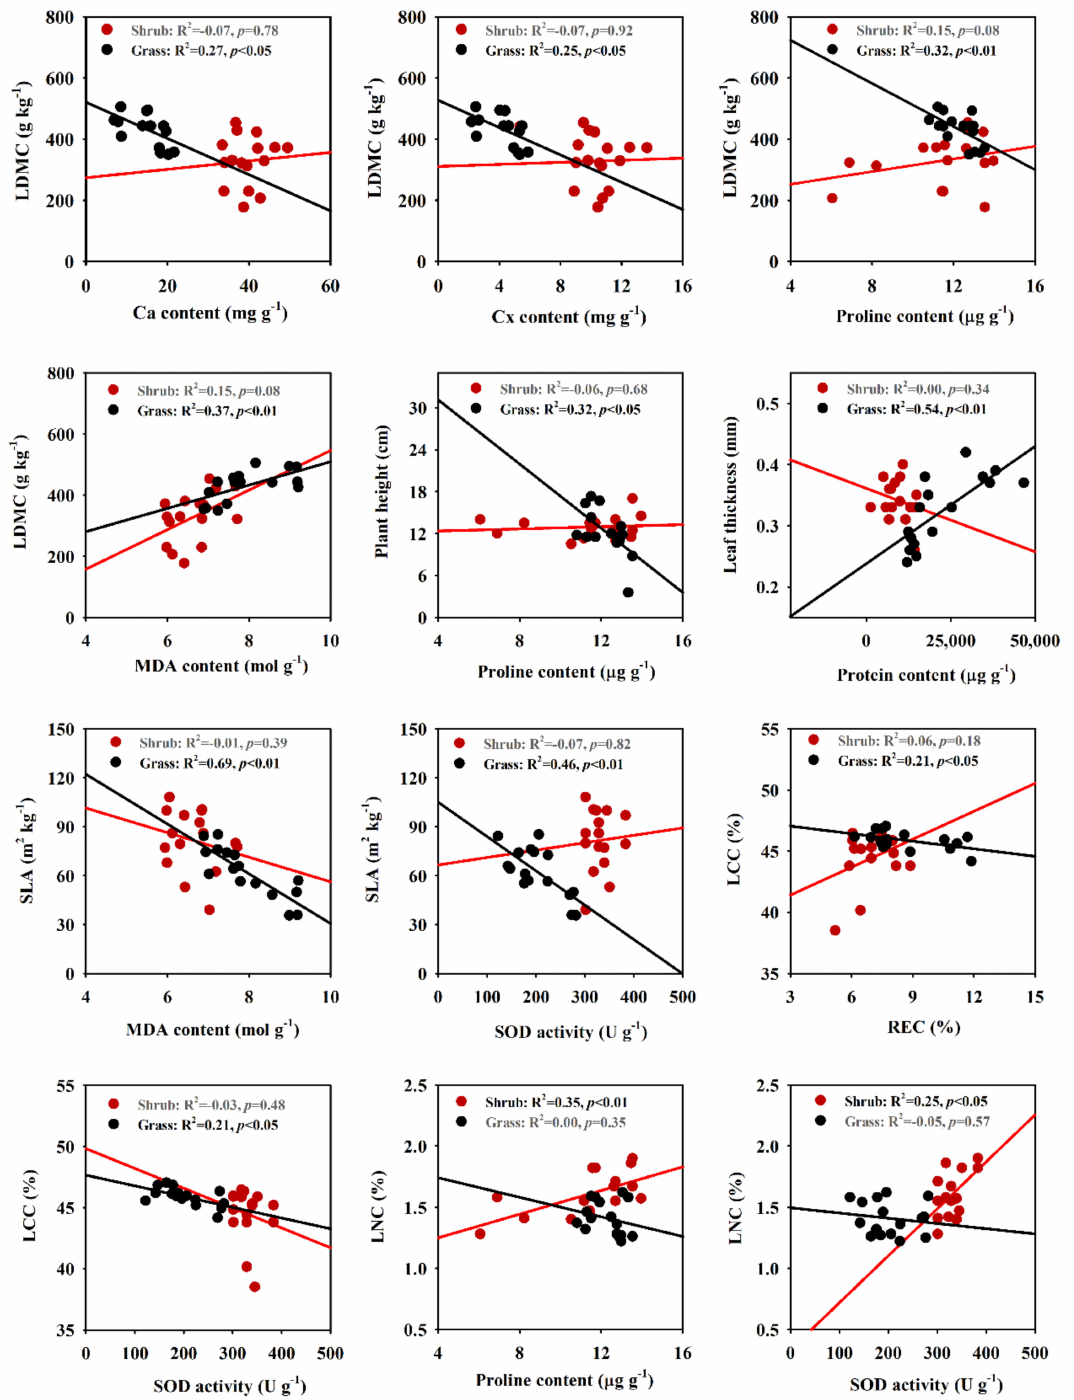
Figure 3. Correlations between functional and biochemical traits of Stipa glareosa in the shrub- and grass-dominated communities. LDMC, leaf dry matter content; Ca, chlorophyll a; Cx, carotenoids; MDA, malondialaenyde; SLA, specific leaf area; SOD, superoxide dismutase; LCC, leaf carbon content; REC, relative electrical conductivity; LNC, leaf nitrogen